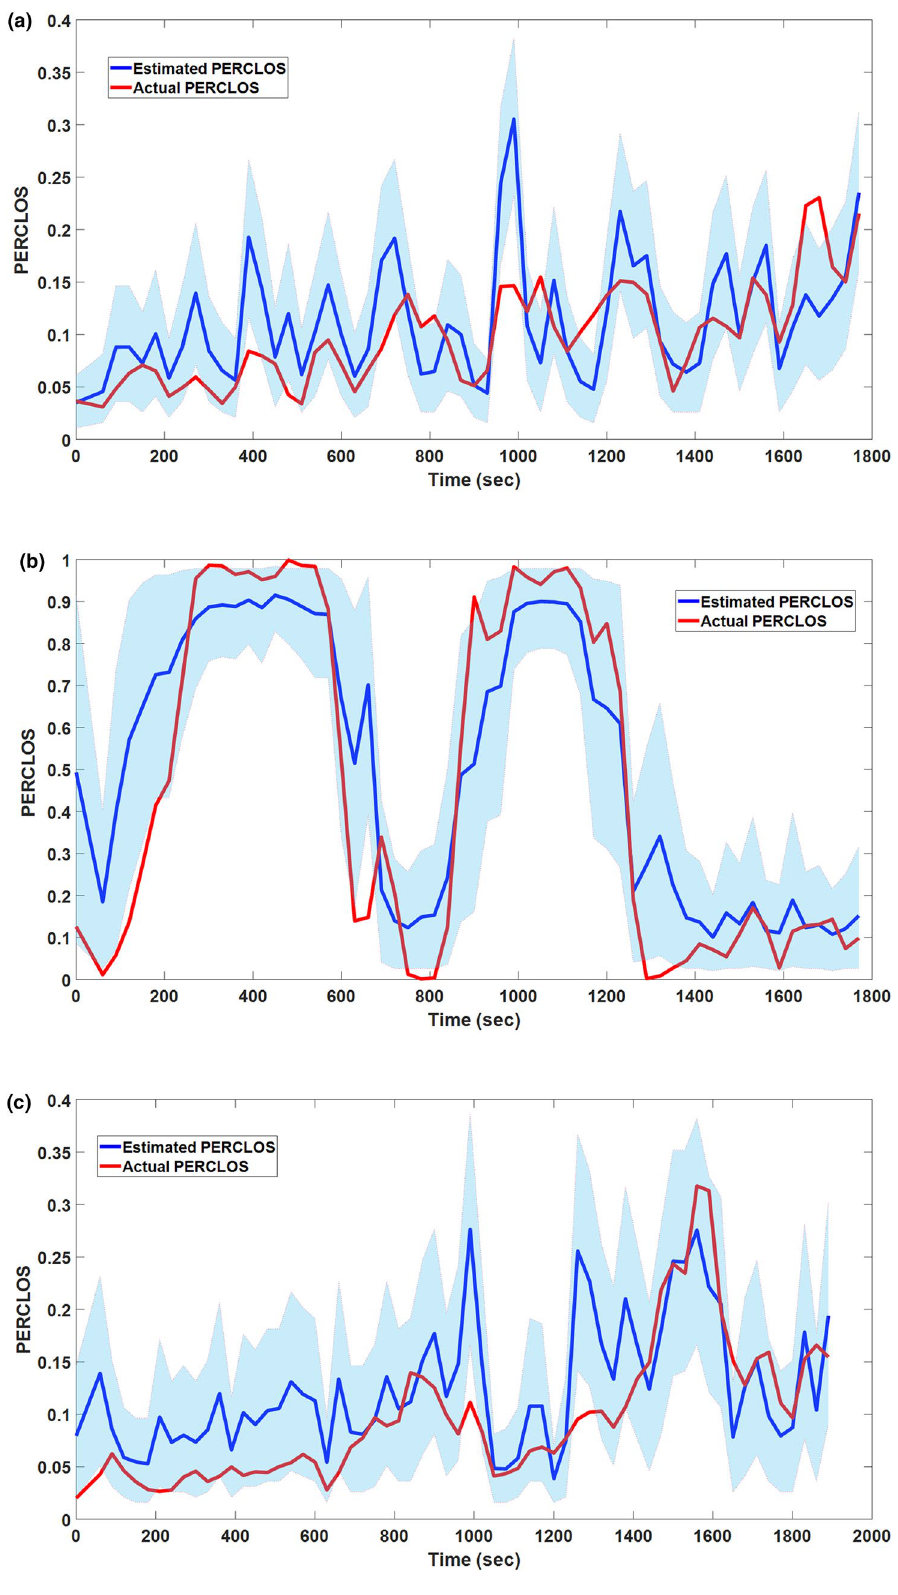
Figure 9. Decoding results in three driving tests with ID=6 ( a ), ID=9 ( b ), and ID=15 ( c ) for estimation of PERCLOS using selected EEG features. Light blue shaded areas show the 95% confidence interval of the estimated PERCLOS. The result suggests a strong correspondence between measured PERCLOS and estimated